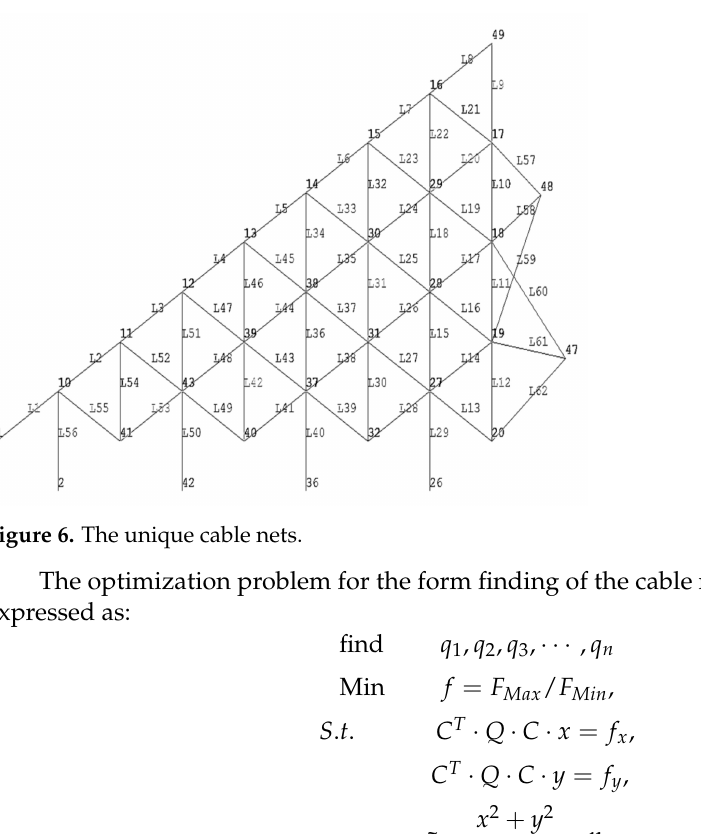
Figure 5. The finite element model for the antenna reflector.